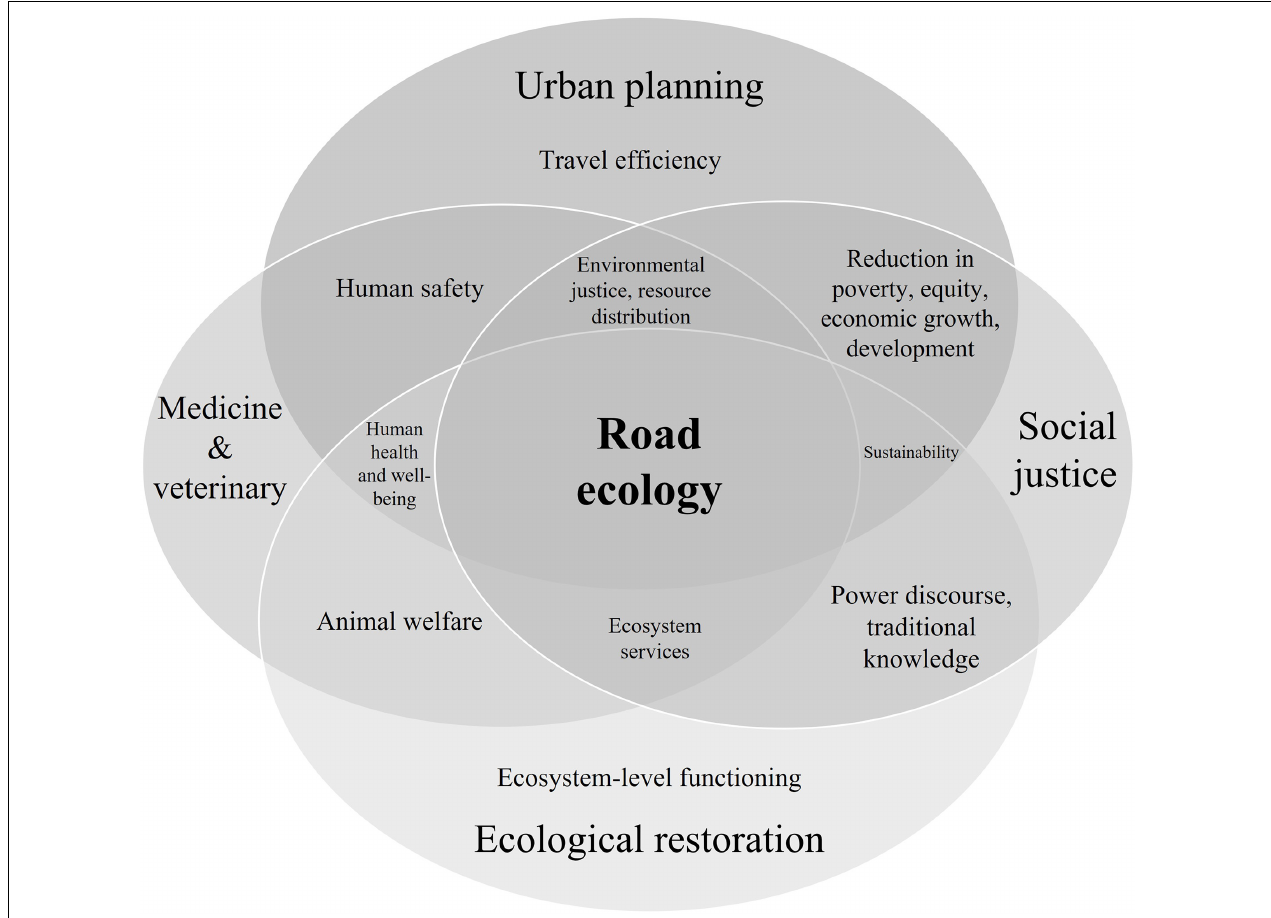
FIGURE 1 | The intersection of the ethical considerations of road ecology with those of several other